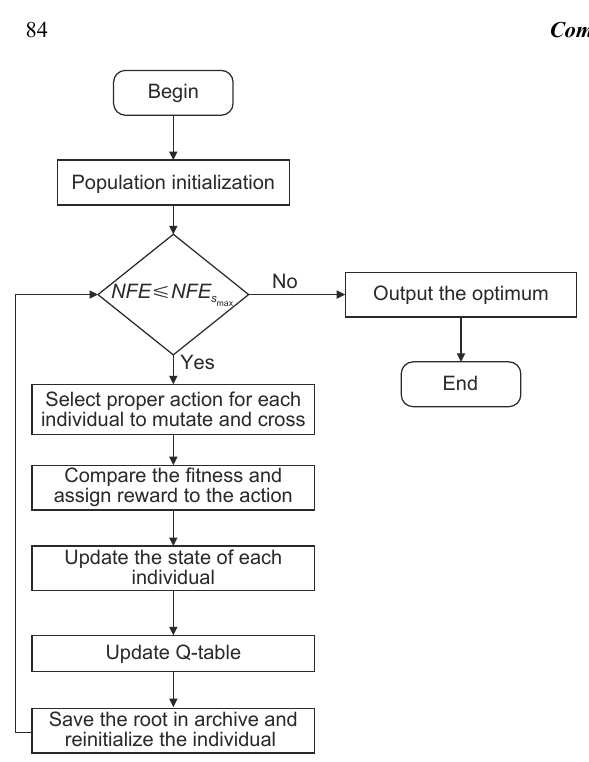
Fig. 2 Flowchart of ERLDE.